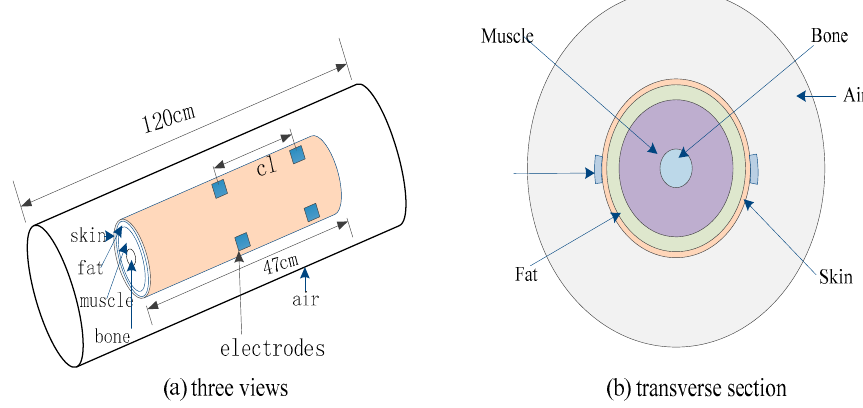
Figure 1. The electric field model of the signal transmission path in the galvanic intra-body communication. ( a ) Three dimensional view of the electric field model; ( b ) Cross section of the electric field model.